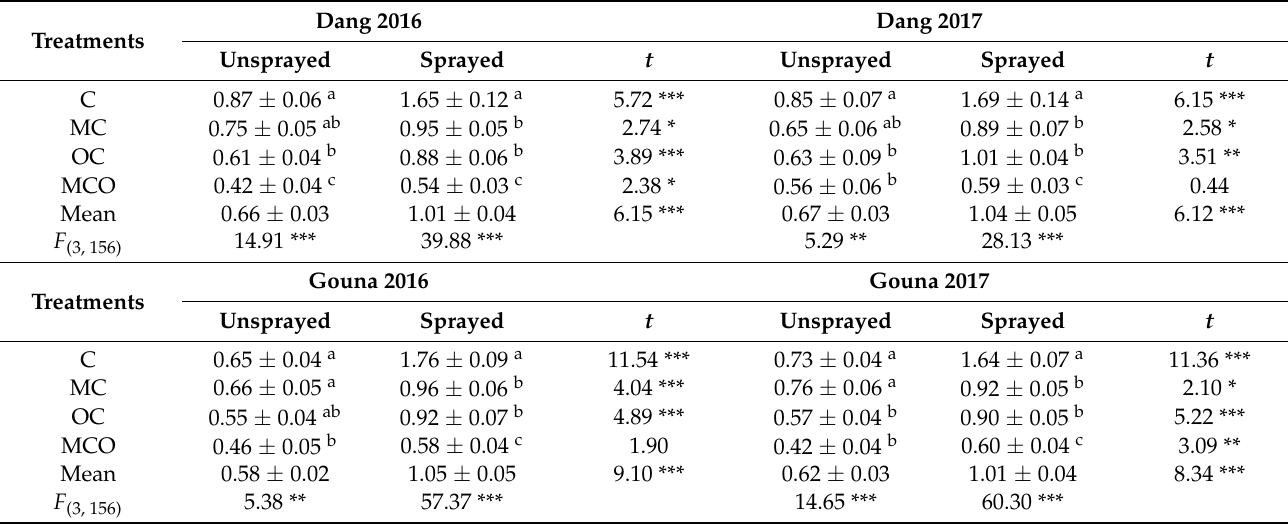
Table 4. Cowpea seed yield (t ha − 1 ) as influenced by Cypermethrin treatments and intercropping system in 2016 and 2017 at Dang and